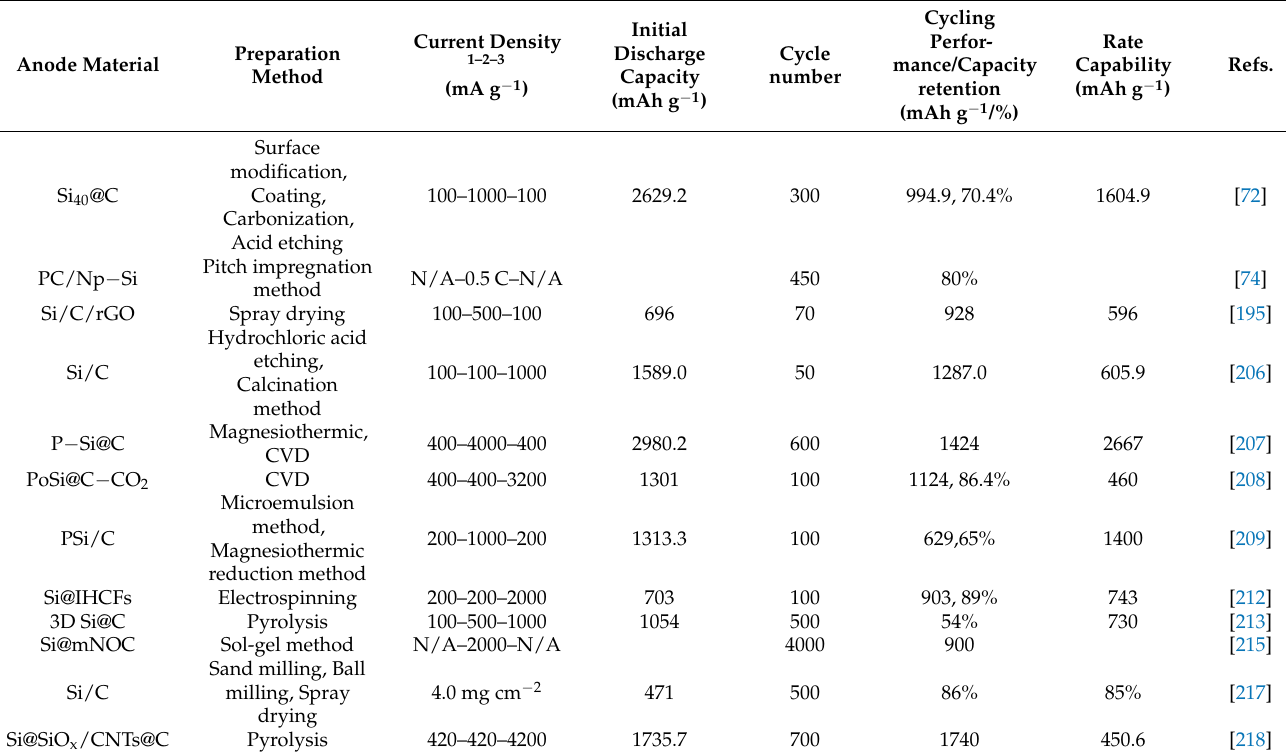
Table 3. Electrochemical performances of porous silicon/carbon anodes for